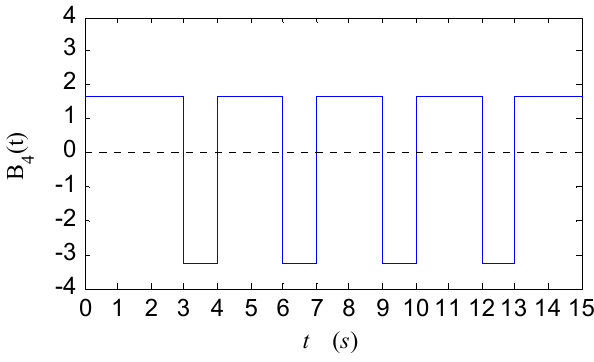
Figure 4. The resource profile of fuzzy place